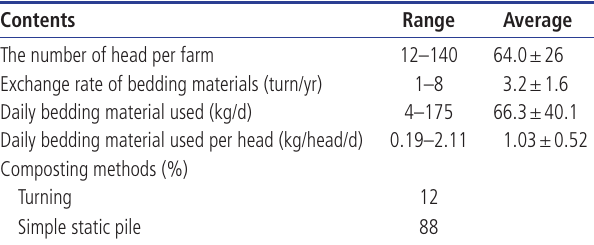
Table 1. Methods of manure management and characteristics of 41 dairy farmsinvestigated